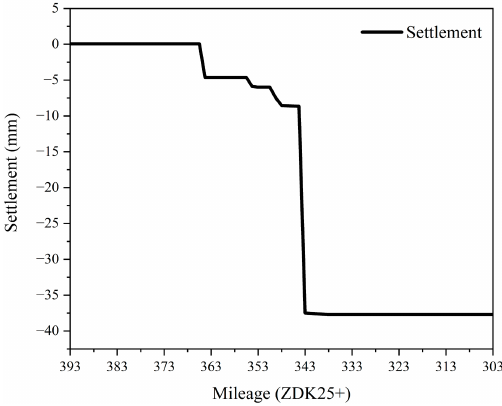
Figure 15. Settlement of the tunnel vault.